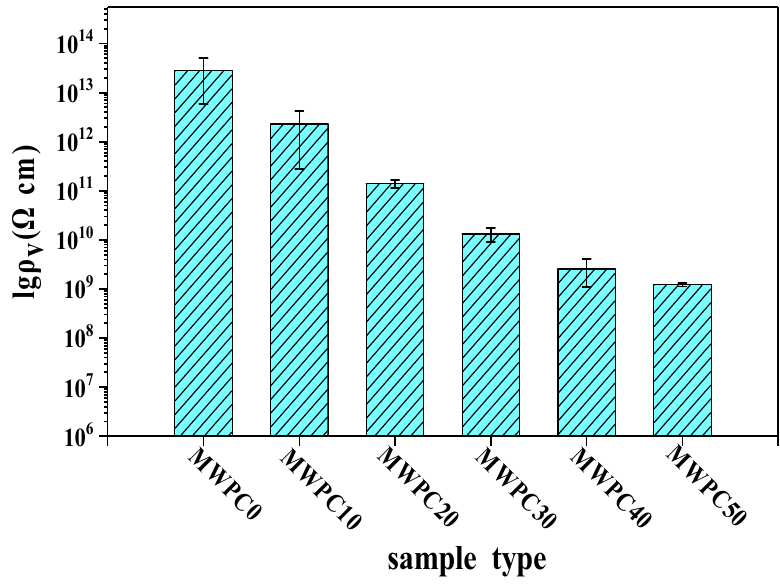
Figure 8. Volume resistivity of biocomposites.